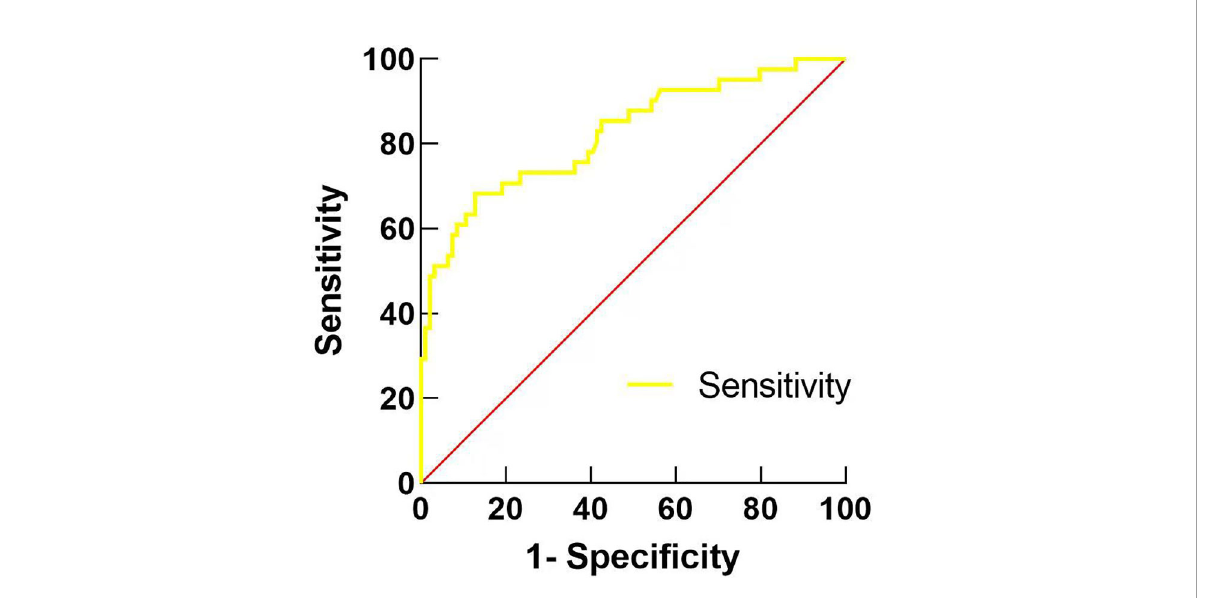
FIGURE 1 ROC curve of stimulated thyroglobulin (ps-Tg) before the fi rst 131 I treatment to predict the best treatment response in 175 patients with intermediate-risk